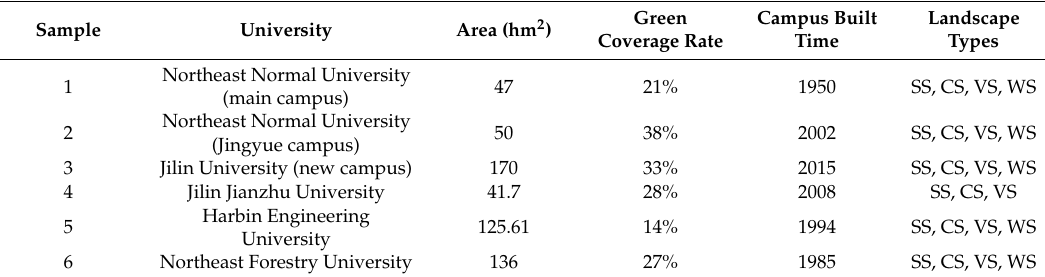
Table 1. Information of the university samples.